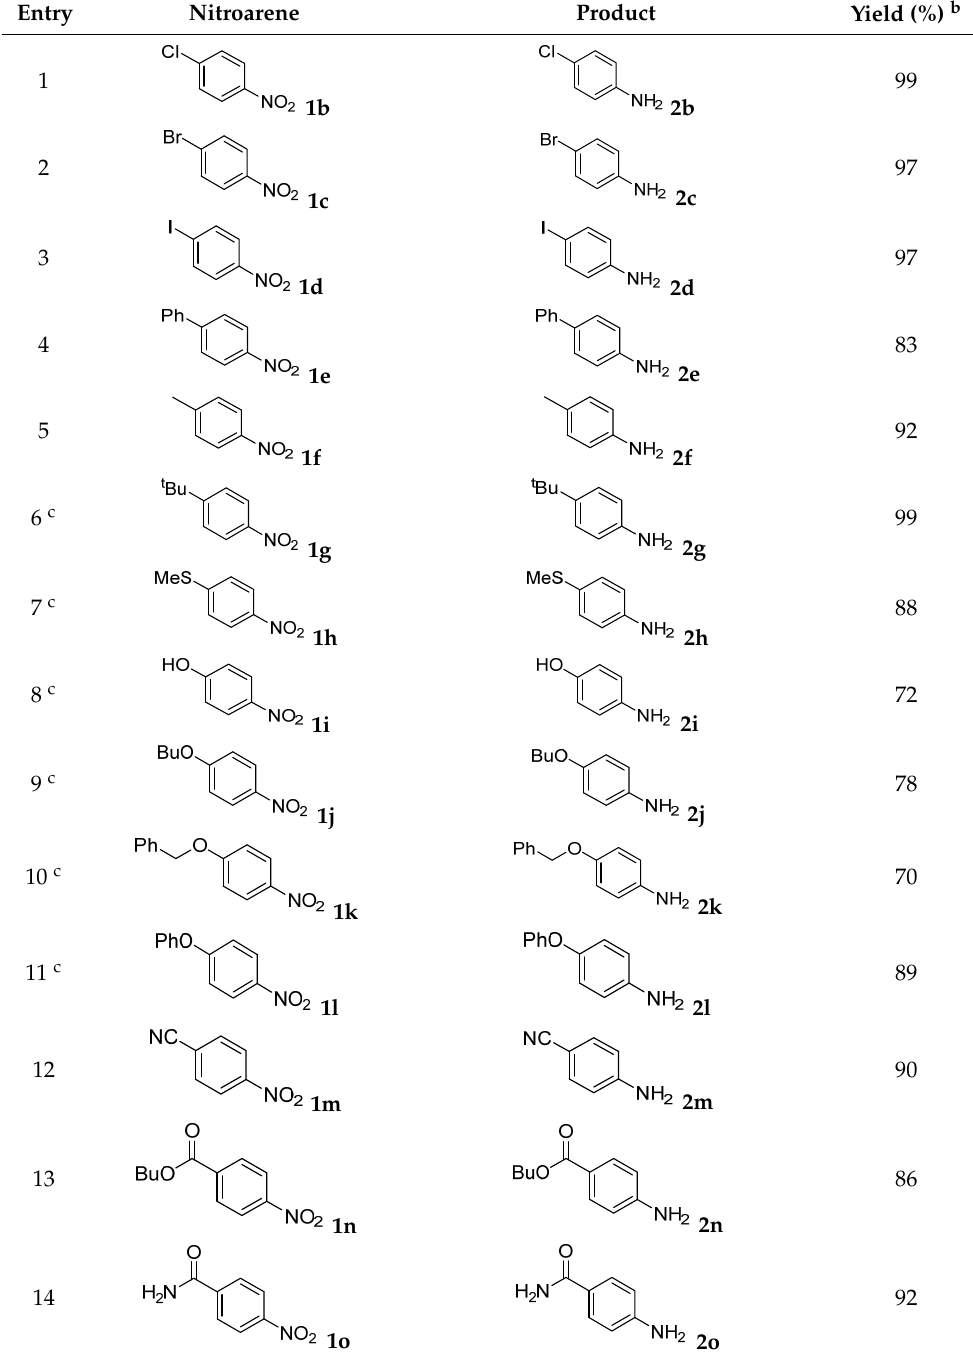
Table 3. Iron–catalyzed hydrogenation of substituted nitroarenes in water a . Table 3. Iron ‒ catalyzed hydrogenation of substituted nitroarenes in water. a . Table 3. Iron ‒ catalyzed hydrogenation of substituted nitroarenes in water. a . Table 3. Iron ‒ catalyzed hydrogenation of substituted nitroarenes in water. a . Table 3. Iron ‒ catalyzed hydrogenation of substituted nitroarenes in water. a . Table 3. Iron ‒ catalyzed hydrogenation of substituted nitroarenes in water. a . Table 3. Iron ‒ catalyzed hydrogenation of substituted nitroarenes in water. a . Table 3. Iron ‒ catalyzed hydrogenation of substituted nitroarenes in water. a . Table 3. Iron ‒ catalyzed hydrogenation of substituted nitroarenes in water. a . Table 3. Iron ‒ catalyzed hydrogenation of substituted nitroarenes in water. a . Table 3. Iron ‒ catalyzed hydrogenation of substituted nitroarenes in water. a . Table 3. Iron ‒ catalyzed hydrogenation of substituted nitroarenes in water. a . Table 3. Iron ‒ catalyzed hydrogenation of substituted nitroarenes in water. a . Table 3. Iron ‒ catalyzed hydrogenation of substituted nitroarenes in water. a . Table 3. Iron ‒ catalyzed hydrogenation of substituted nitroarenes in water. a . Table 3. Iron ‒ catalyzed hydrogenation of substituted nitroarenes in water. a . Table 3. Iron ‒ catalyzed hydrogenation of substituted nitroarenes in water. a . Table 3. Iron ‒ catalyzed hydrogenation of substituted nitroarenes in water. a . Table 3. Iron ‒ catalyzed hydrogenation of substituted nitroarenes in water. a . Table 3. Iron ‒ catalyzed hydrogenation of substituted nitroarenes in water. a . Table 3. Iron ‒ catalyzed hydrogenation of substituted nitroarenes in water. a . Table 3. Iron ‒ catalyzed hydrogenation of substituted nitroarenes in water. a . Table 3. Iron ‒ catalyzed hydrogenation of substituted nitroarenes in water. a . Table 3. Iron ‒ catalyzed hydrogenation of substituted nitroarenes in water. a . Table 3. Iron ‒ catalyzed hydrogenation of substituted nitroarenes in water. a Entry Entry Entry Entry Entry